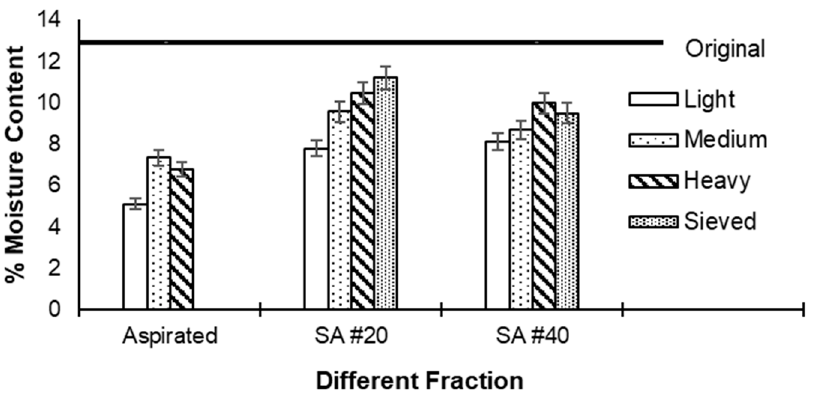
Figure 1. Moisture content variation of the different fractions.